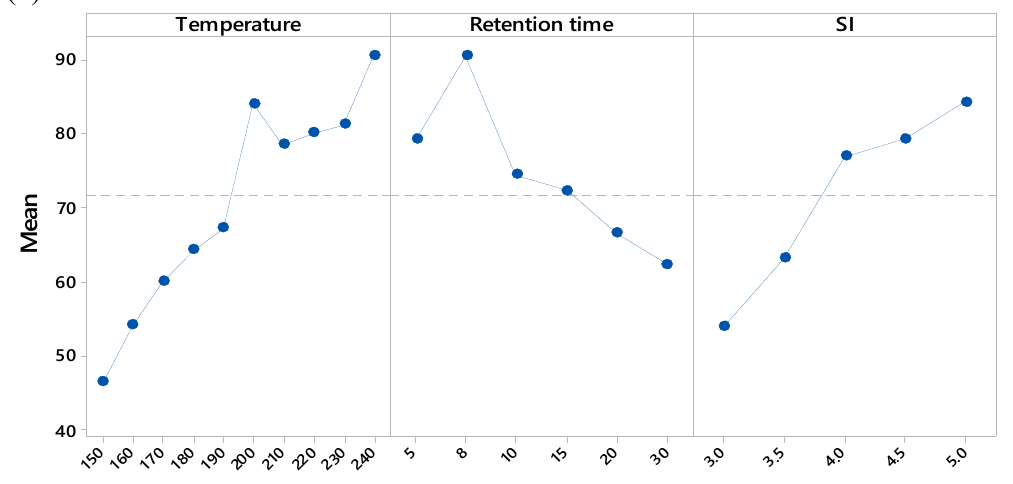
Table 4. Concentration of soluble compounds after acidification for the raw and pretreated samples. SI